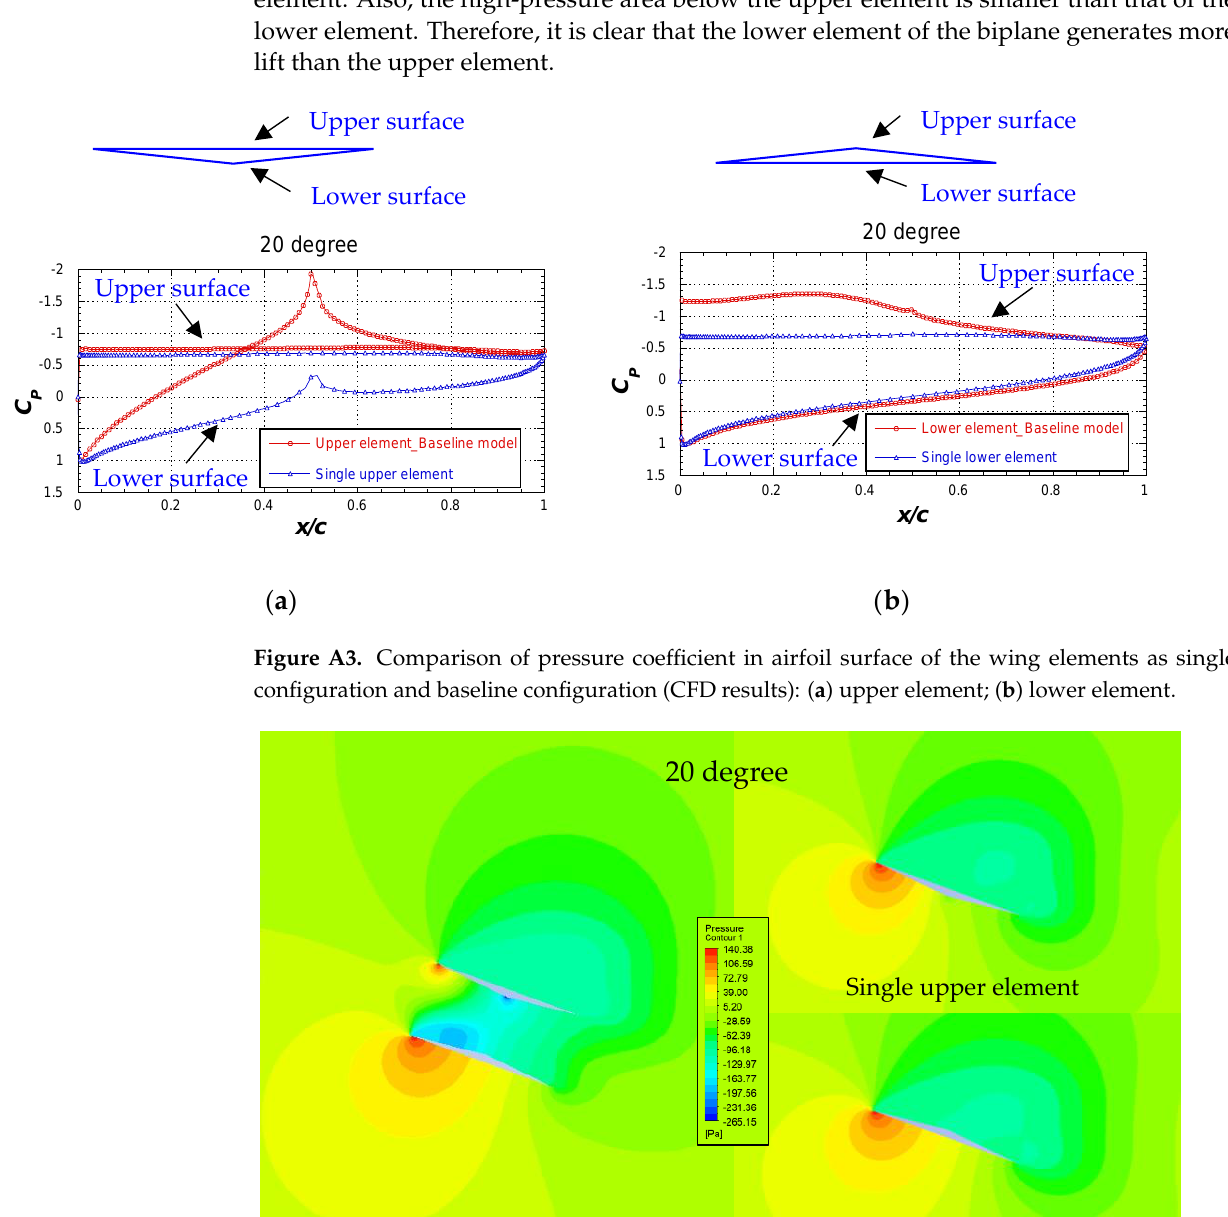
Figure A1. Grid independence of numerical simulation for baseline model: ( a ) grid convergence at 0 degrees; ( b ) lift-and-drag ratio of 4 mesh systems.